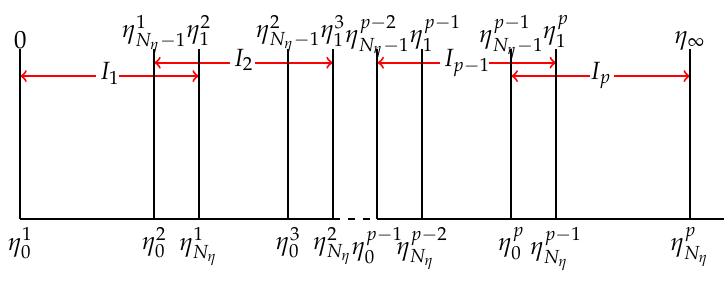
Figure 2. Non-overlapping grid ( ξ -domain).